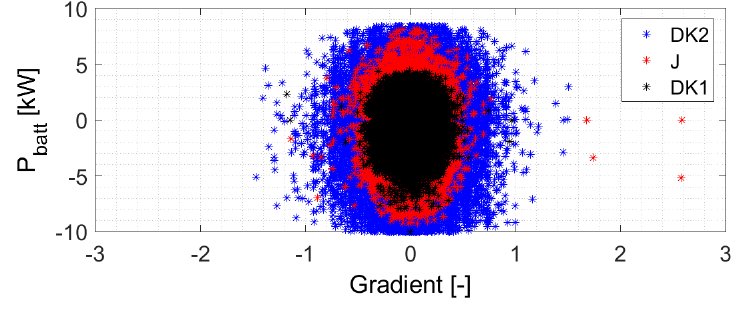
Figure 10. Battery power as function of the gradient of the battery power for DK1, DK2 and